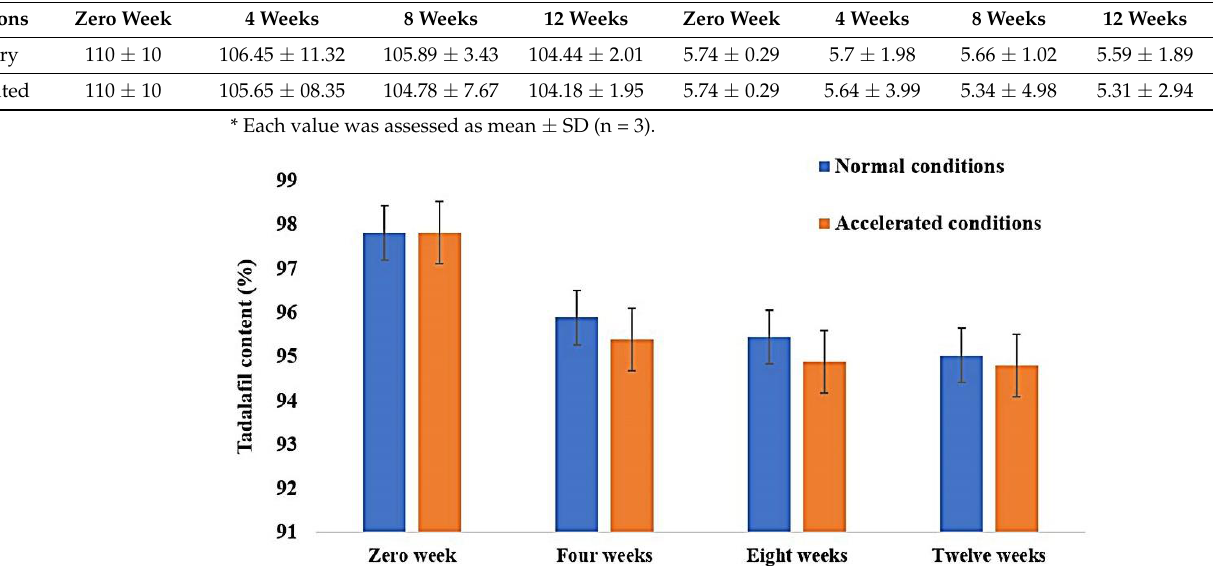
Figure 6. Tadalafil content in the oral niosomal film after storage under different conditions. Each value represents mean ± SD (n = 3).